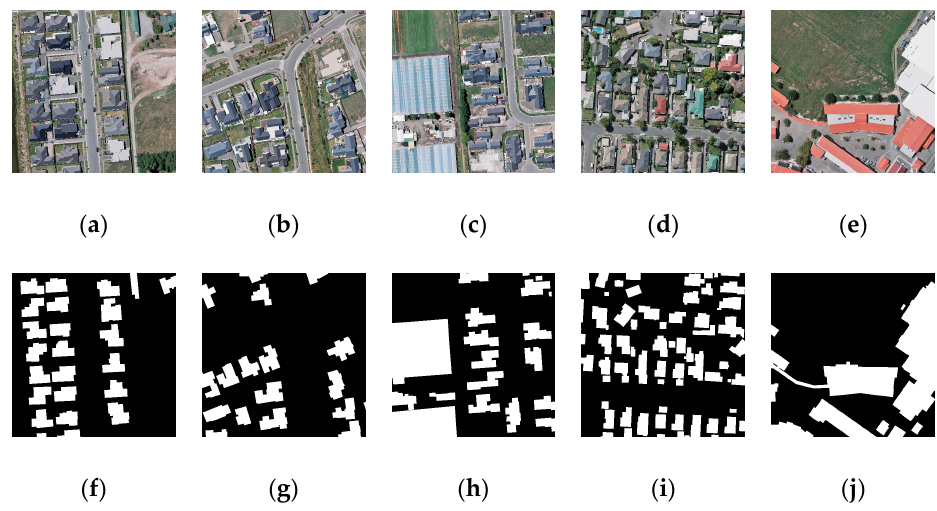
Figure 12. WHU building dataset sample data. ( a – e ) Images. ( f – j ) Labels.